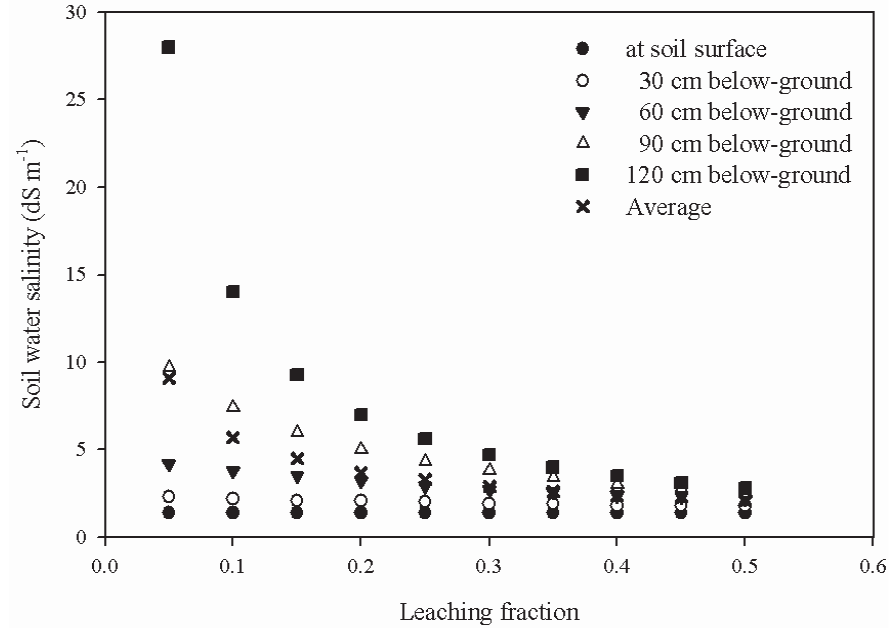
Figure 2. Simulated average soil water salinity (expressed as electrical conductivity) at the soil surface, 30 cm, 60 cm, 90 cm and 120 cm below ground and average root-zone salinity resulting from different leaching